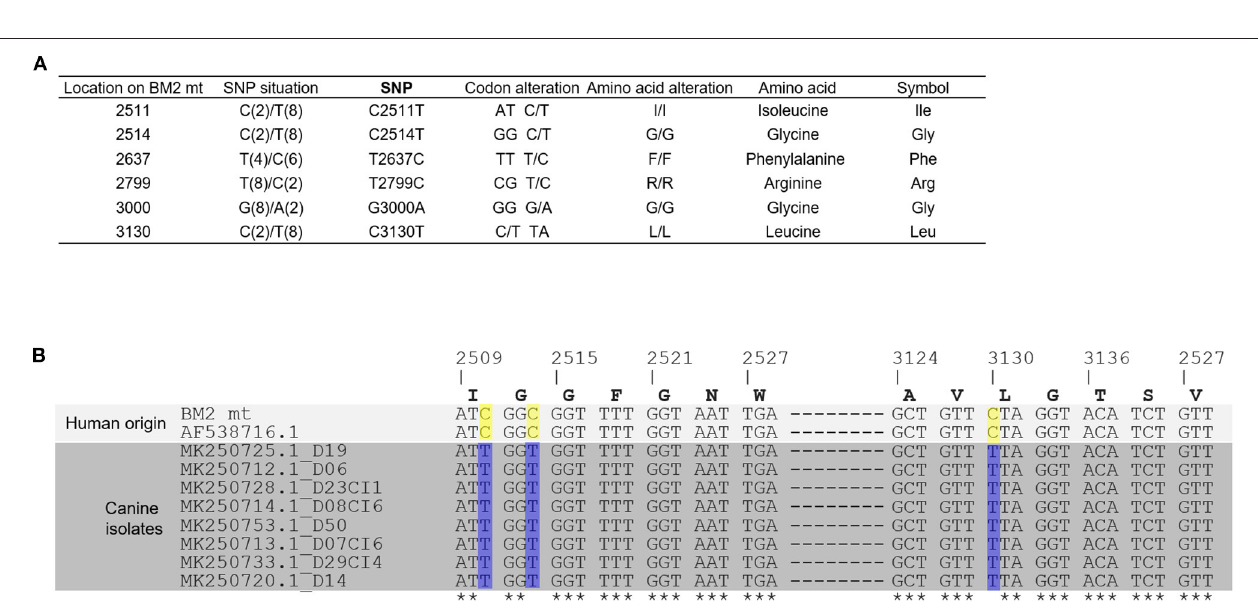
FIGURE 4 | Single nucleotide polymorphism of COX1 . COX1 genes of B. malayi were obtained from FR3 strain and from those isolated in dogs (D19, D06, D23CI1, D08CI6, D50, D07CI6, D50, D07CI6, D29CI4, and D14). (A) Types and locations of SNPs in the assembled mt DNA sequence. Six SNP sites were presented in which each nucleotide type was supported by at least two sequences, while other SNP sites caused by only one sequences were listed in the Supplementary Table 3 . No SNP alterations caused a change in the type of amino acid. (B) COX1 genes of BM2 mt and other nine isolates were subjected to multiple sequence alignment using CLUSTAL OMEGA. The locations of the C/T SNPs located at 2,511, 2,514, and 3,130 were able to separate 10 B. malayi isolates into two types: human or canine origin.